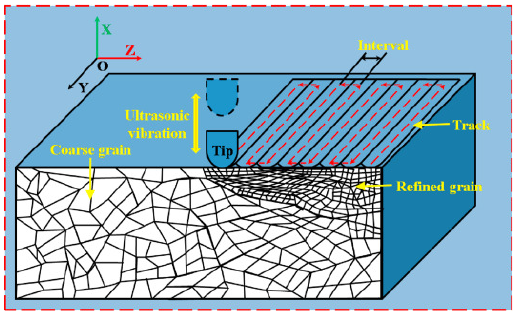
Figure 7. Schematic illustration of the UNSM process reprinted from ref. [29]. Copyright 2022 ELSEVIER.